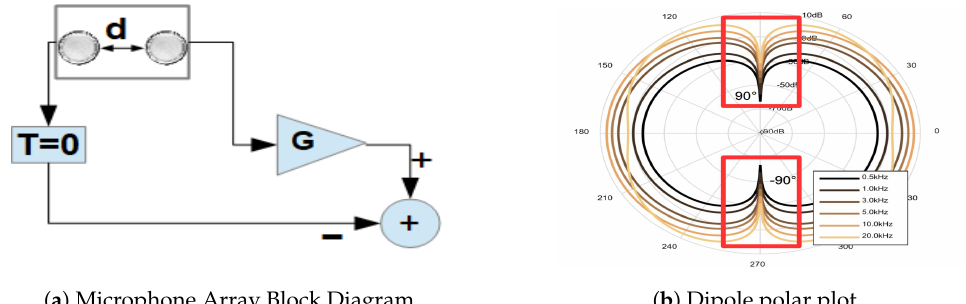
Figure 3. ( a ) First Order Differential Microphone Array Block Diagram. With G as a gain factor, d space between microphones and T time-delay between microphones. ( b ) Polar plot of first order differential microphone array(frequency vs angle of arrival). With an inter-microphone space of 16 mm, distance from the source of 50 cm, and frequencies 0.5, 1, 3, 5, 10 and 20 kHz and sound rejection at ± 90 degrees(red boxes). Diagram by STMicroelectronic